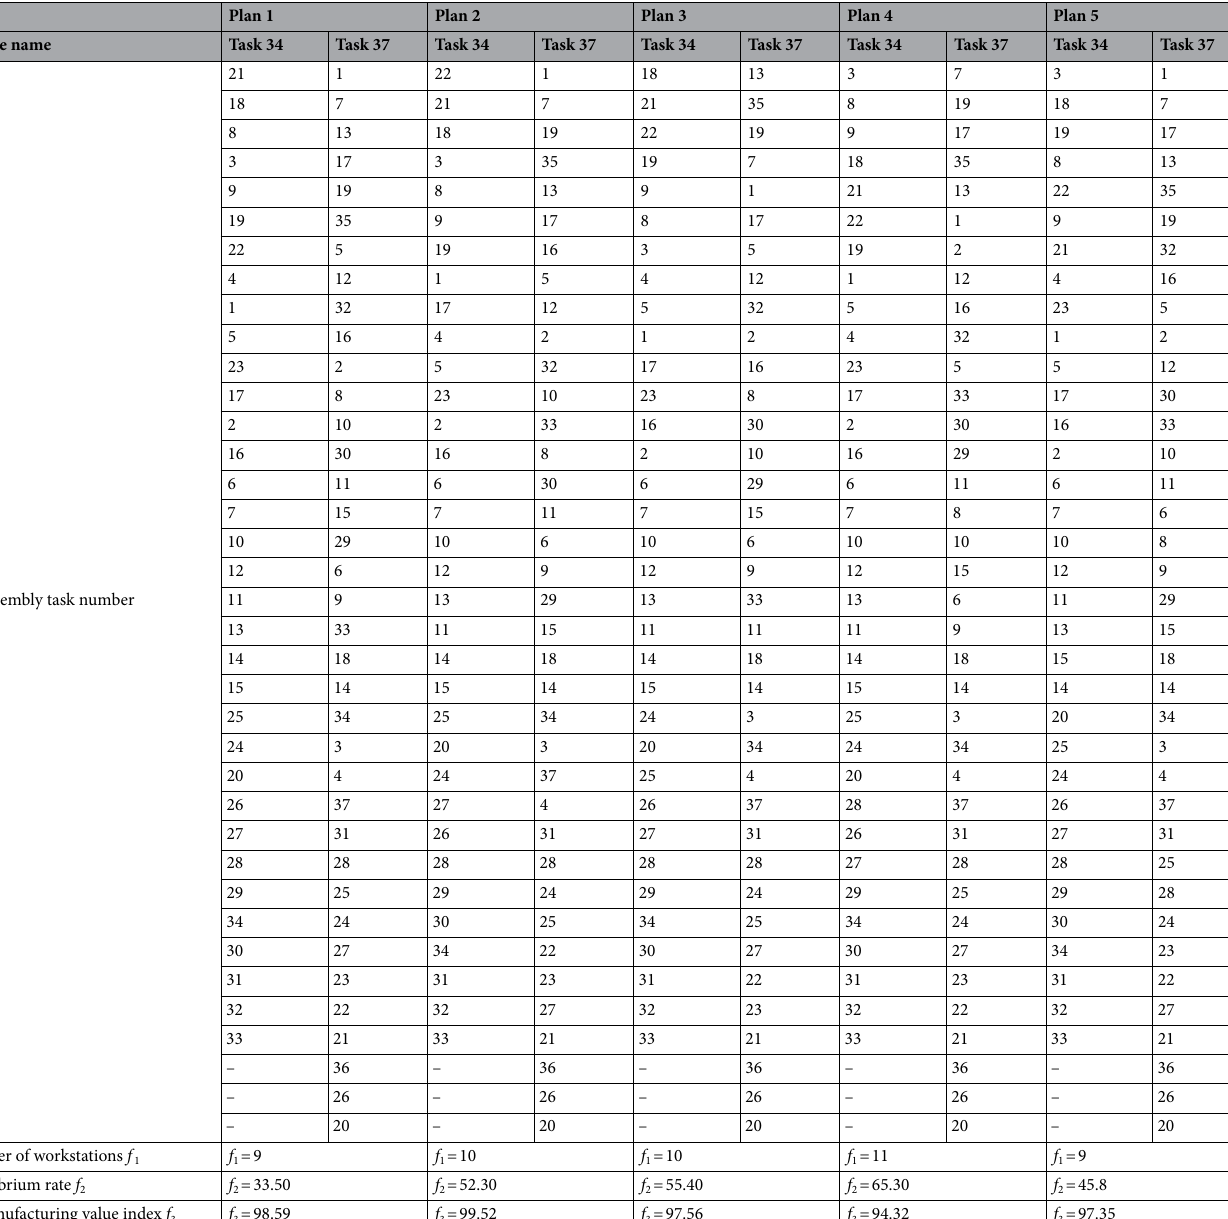
Table 5. Optimal PMRDLB